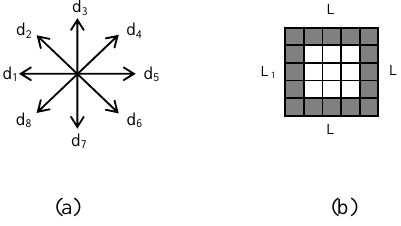
Figure 5. a Eight discrete directions. b The four sides of a 5 × 5